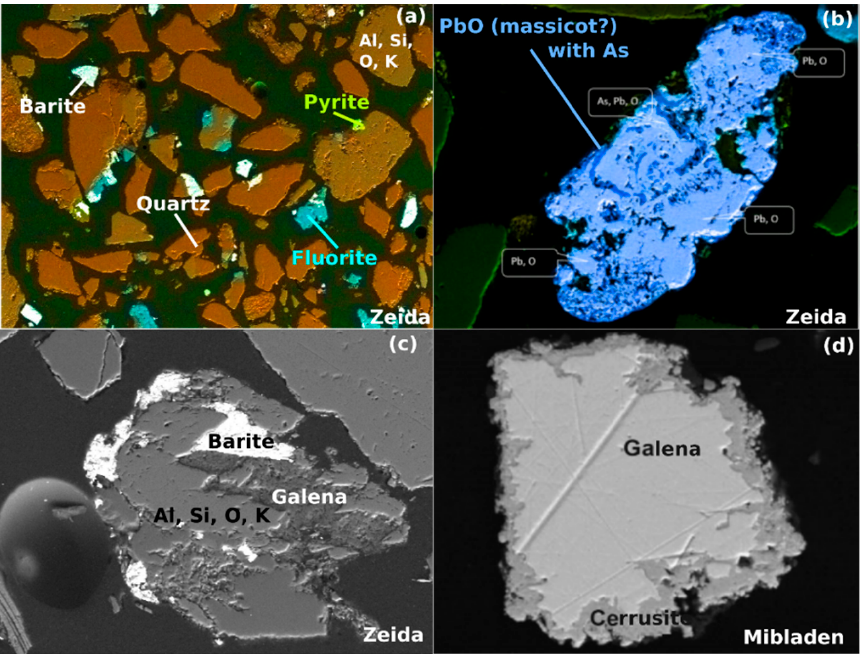
Figure 1. SEM images of the mining tailings at the Zeida and Mibladen sites; minerals are indicated if correctly identified, and the atomic composition is provided otherwise, ( a ) global view of Zeida mining waste, ( b ) grain of massicot, ( c ) grains of galena and barite in association with aluminosilicates, ( d ) grain of galena which alteration provide cerussite.